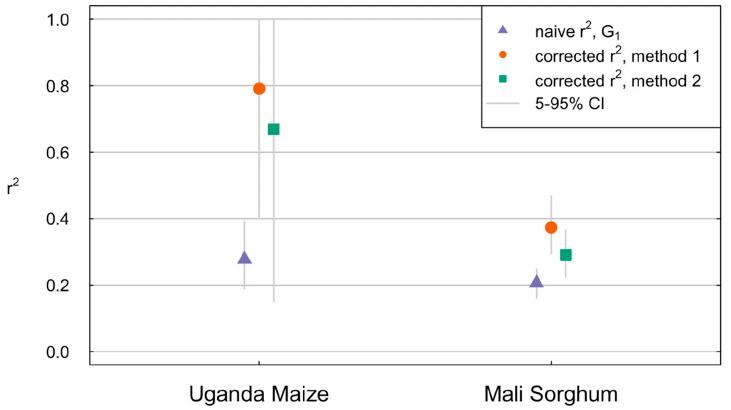
Figure 5. Satellite measures of in-field heterogeneity can substitute for a second crop-cut. Comparison of naive r 2 for a regression of satellite-based yields on crop-cut yields ( G 1 ), the corrected r 2 using self-report yields and Equation (14) as in Figure 3 (method 1), and corrected r 2 using satellite-based estimates of the correlation between two crop-cuts and Equation (15) (method 2). The confidence intervals (gray bars) were calculated by resampling the fields and recalculating the different r 2 val- ues.